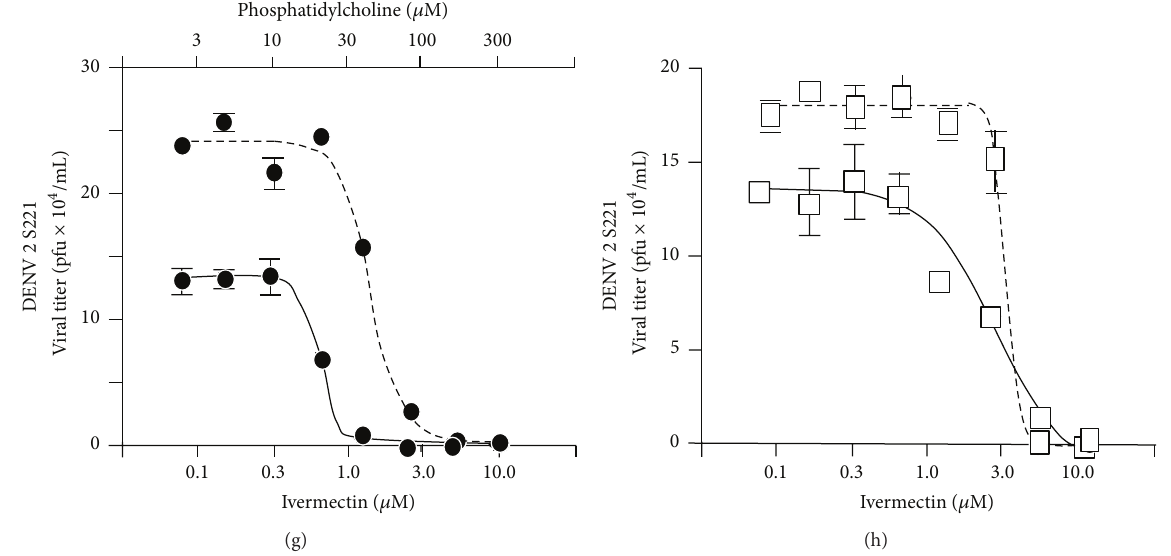
Figure 11: In vitro antiviral effect of ivermectin formulated in liposomes on Huh-7 cells infected with DENV 1. Ivermectin (d) and the following liposomal formulations were tested: #PC3-Ch1-ive0.1 (a), #PC3-Cl1-ive0.1 (b), and #PC3-Br1-ive0.1 (c). In vitro antiviral effect of ivermectin formulated in liposomes on Huh-7 cells infected with DENV 2 (plain lines) and DENV 2 mouse adapted S221 strain (dashed lines). The following liposomal formulations were tested: #PC3-Ch1-ive0.1 (e), #PC3-Cl1-ive0.1 (f), and #PC3-Br1-ive0.1 (g). For comparison, data relative to the free ivermectin are reported in (h). The related empty liposomes do not have any effect on the cells. The phosphatidylcholine concentration (top 𝑥 -axis) is related to empty liposomes while the ivermectin concentration (bottom 𝑥 -axis) is related to ivermectin liposomes. Details on the identification codes and liposomal compositions are included in Table 1. Details on the EC 50 values are in Table 3. Data represent the average of 2 determinations ± SD.